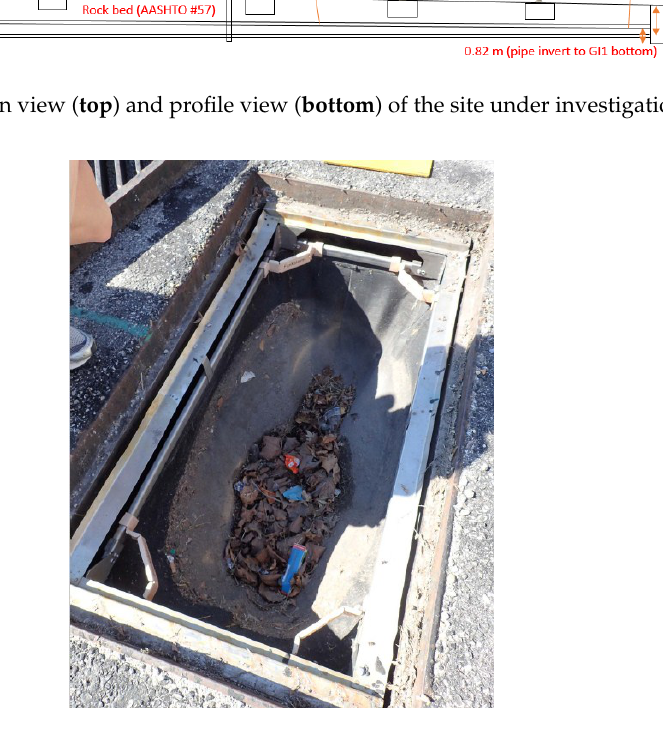
Figure 2. Trash guard installed in the GI1 inlet structure (Date: 18 October 2016).